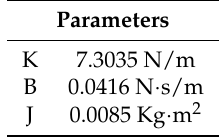
Table 3. Estimated Joint Parameters.